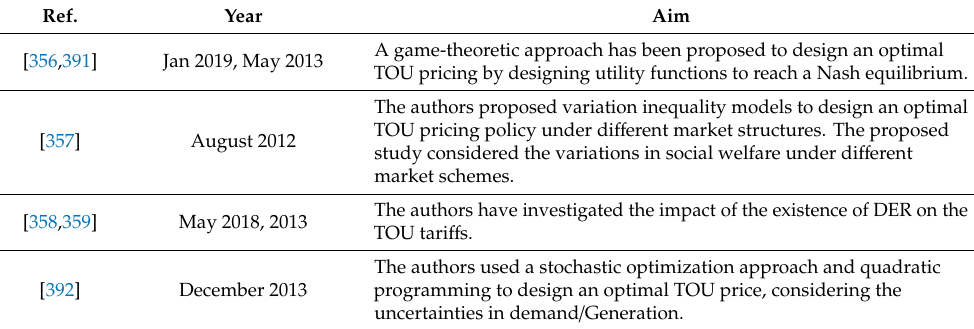
Table 11. Recent advances in time-of-use (TOU)